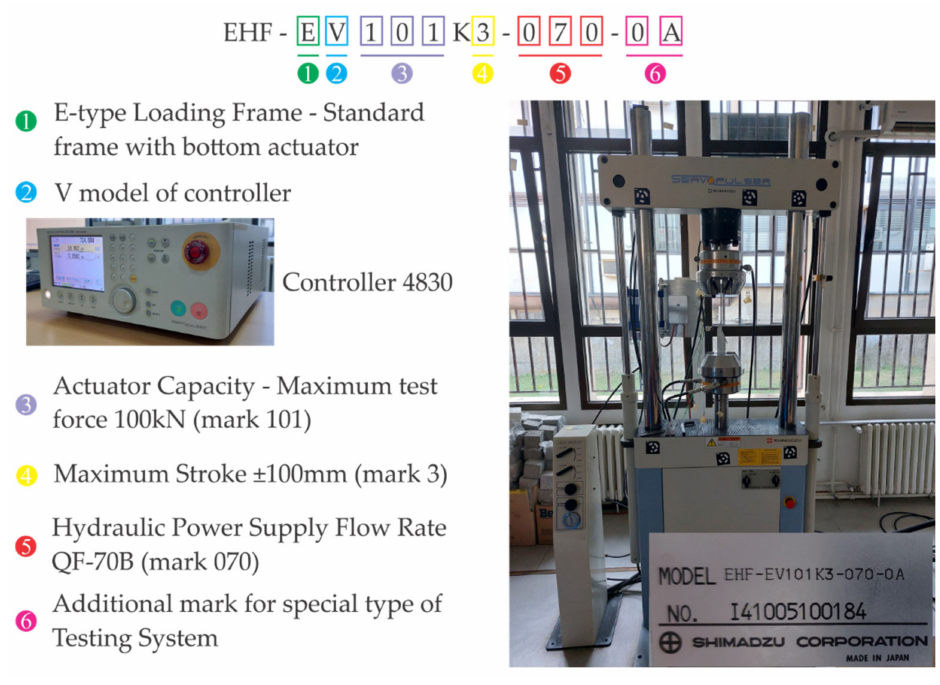
Figure 2. SHIMADZU servo-hydraulic machine.